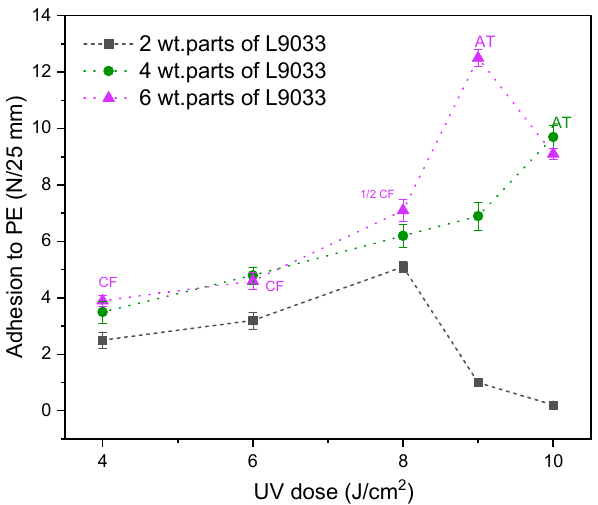
Figure 8. Adhesion of PSA with FT5/L30 to PE in relation to UV dose and aliphatic urethane acrylate content (CF—cohesive failure; 1/2CF—partial cohesive failure; AT—adhesive transfer to the PE sur- face).